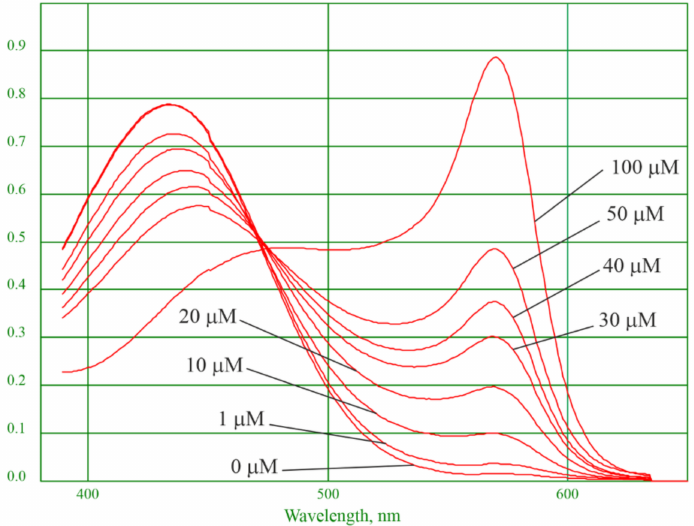
Figure 2. Calibration spectra with different concentrations of the gadolinium cation in the XO